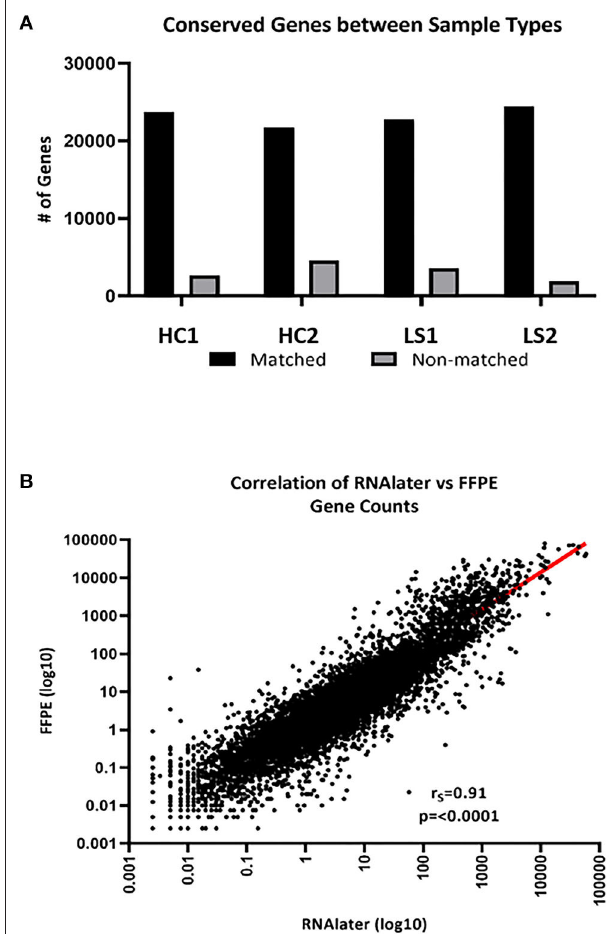
FIGURE 2 | FFPE and FF (RNAlater) generated data sequencing and mapped well per sample type. (A) An average of 92% of total genes was conserved between sample types. HC, healthy control and LS, localized scleroderma. (B) Of the conserved genes, gene expression correlated significantly ( r s = 0.91, p < 0.0001).